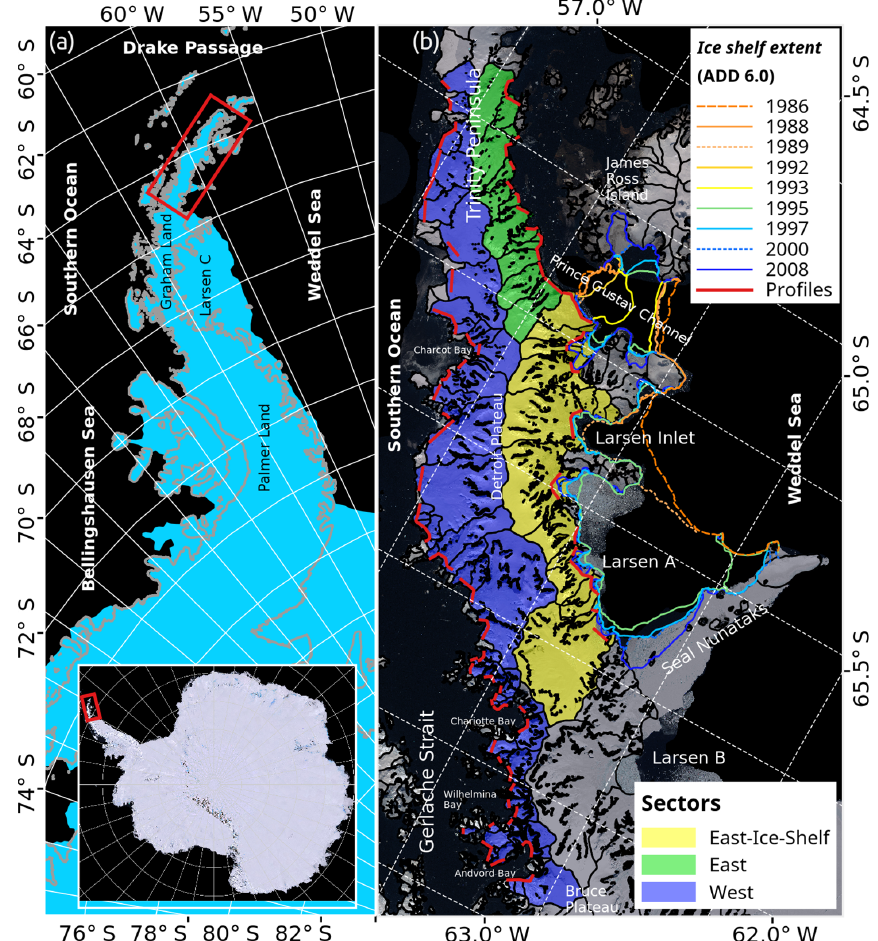
Figure 1. (a) Location of study site on the Antarctic Peninsula and on the Antarctic continent (inset). (b) Separation of study site in three sec- tors and retreat states of Prince Gustav and Larsen A ice shelves. Red lines: profiles at glacier front for velocity measurements. Map base, Landsat LIMA Mosaic USGS, NASA, BAS, NSF, coastlines (ice shelf extent) and catchment delineations are from SCAR Antarctic Digital Database